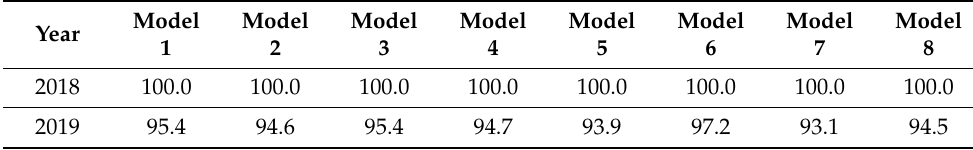
Table A1. Sensitivity mdels * of the national bike traffic